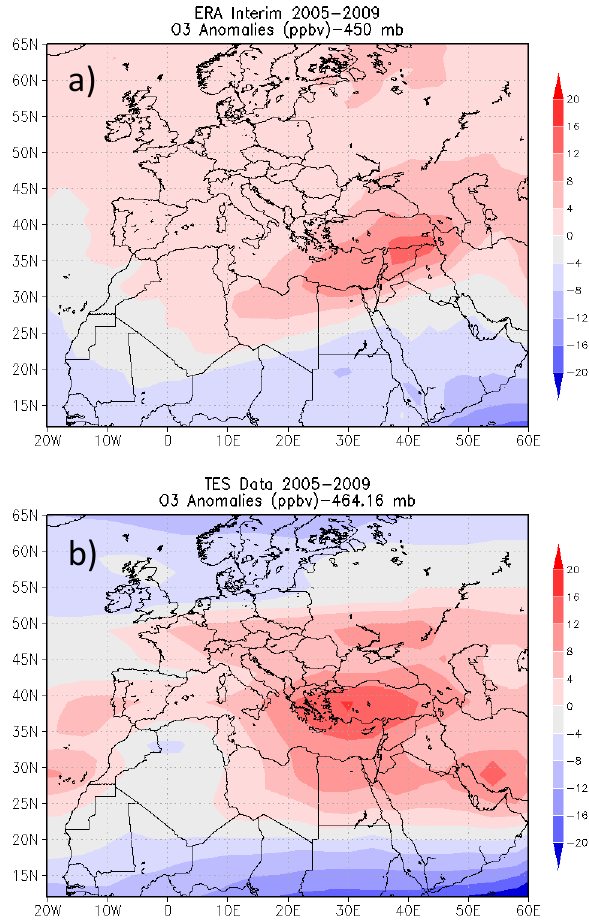
Fig. 3. July–August average ozone anomaly fields (ppbv) over the Figure 3. July-August average ozone anomaly fields (ppbv) over the period 2005- 883 period 2005–2009 based on (a) ERA-Interim ozone at 450hPa, and 2009 based on a) ERA-interim ozone at 450 hPa, and on b) TES observed ozone at 884 on (b) TES observed ozone at 464mb. Ozone anomalies were calcu- 464 mb. Ozone anomalies were calculated as the differences between the July-August 885 lated as the differences between the July–August mean at each grid point and the July–August mean of the whole area of the mean at each grid point and the July-August mean of the whole area of the domain. 886